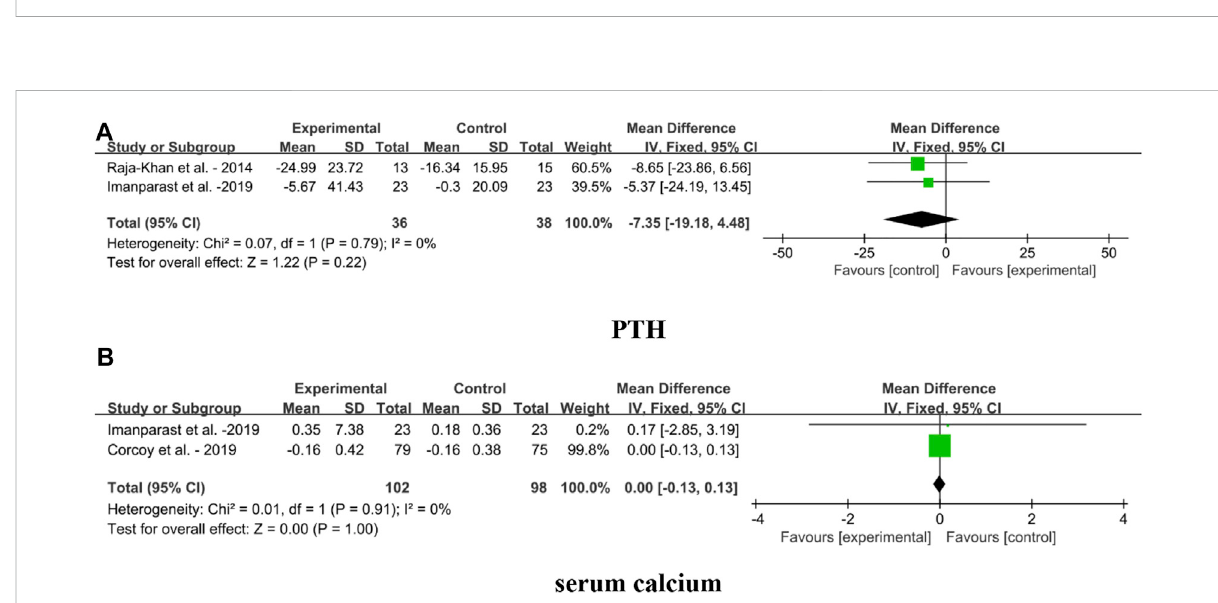
FIGURE 8 Forest plots for the effects of VDS on VDT biomarkers in MetS adults. (A) PTH: parathyroid hormone, (B) serum calcium. The horizontal bar indicatesthe95%con fi denceinterval(CI).Thesizeoftherectangleatthecenterofthehorizontalbarisproportionaltotheweightofthegivenstudy. The diamond at the bottom indicates the pooled mean difference